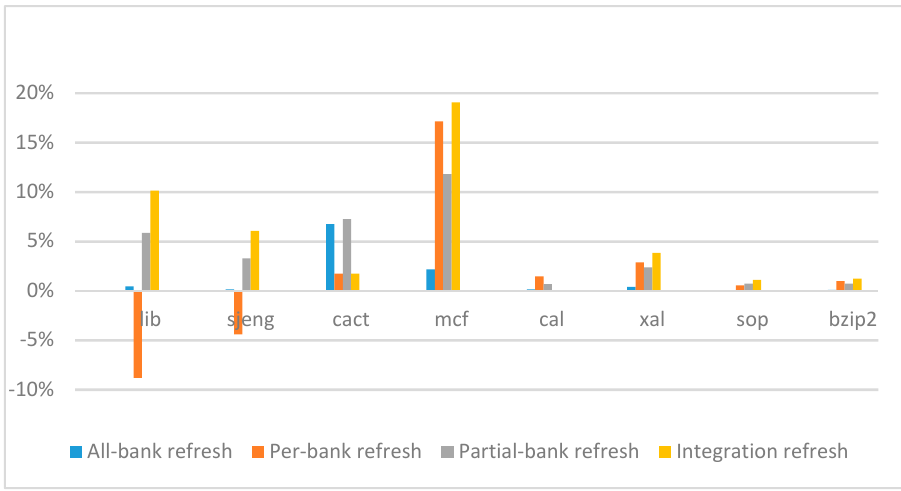
Figure 16. IPC improvement normalized to 1x granularity baseline (tRFC = 530 ns, weak row = 3%). Micromachines 2019 , 10 , x